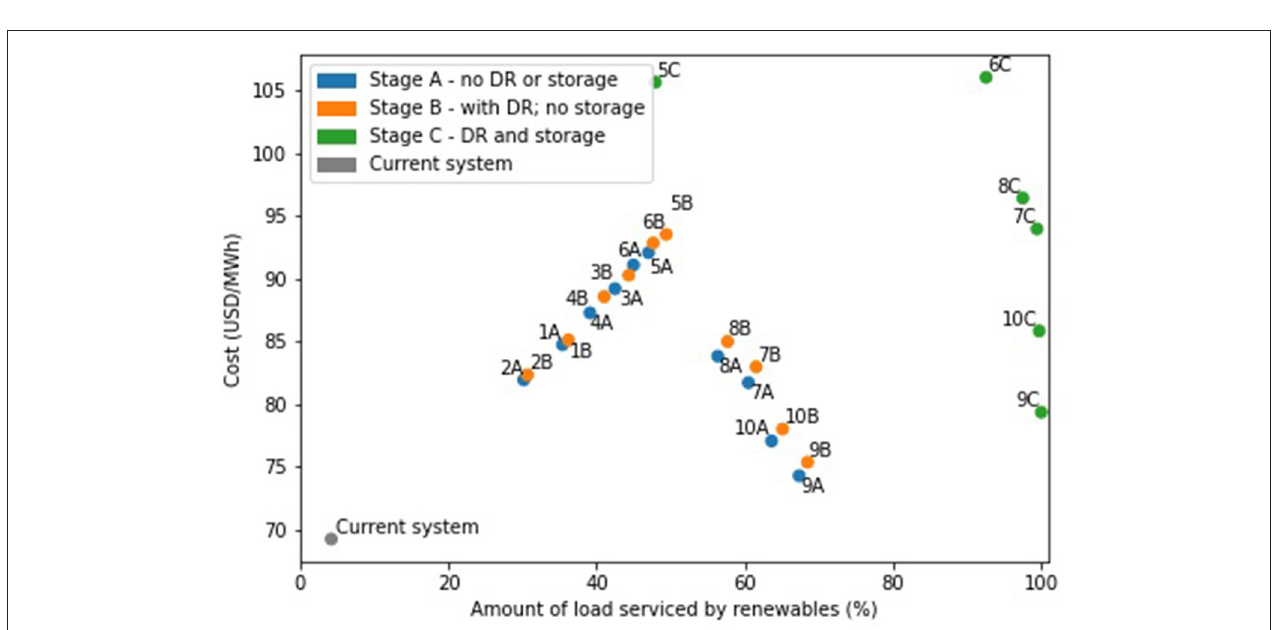
FIGURE 8 | Modeled cost of electricity system per unit energy compared to ability to meet Regina’s renewable target with a carbon tax of 170 CAD. As previously outlined, odd numbered scenarios have 50% electrification levels; even numbered scenarios have 100% electrification levels; and Scenarios 7 through 10 have additional wind capacity along with rooftop